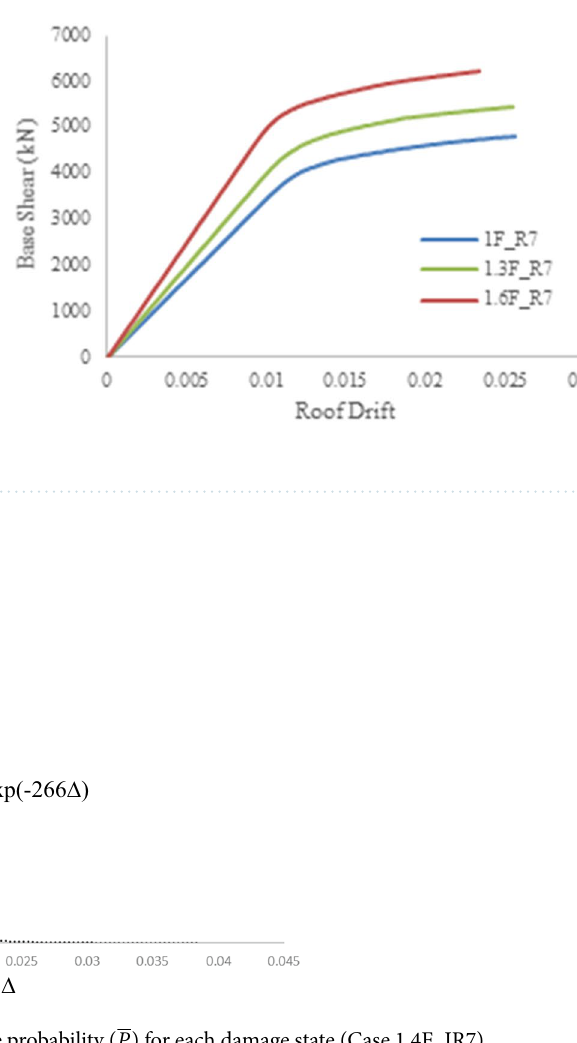
are applied in a displacement-controlled manner in 100 incremental steps until the loads reached the target displacement for each structure, according to ASCE41-17. Afterward, the pushover curve is obtained for each structure. The target displacement for the three AEP (i.e., PGA of 0.58, 0.35, and 0.18 g) is determined for the earthquakes with the exceedance probabilities of 2, 10, and 50% in 50 years. For instance, the pushover curves for three types of 7-story regular structures and the structures designed based on the design earthquake of all four types are presented in Fig. 6. Figure 7 and Table 3 describe the objective function of LCC for the 1.4F_IR7 model. The objective function for the model is described as follows: the pushover analysis result provides three pairs of maximum inter-story Fig. 7. The derived function is used to calculate the annual exceedance probability, P, of the seven damage states listed in Table 1. The P values are substituted into the Eqs. (6) and (7) to calculate the LCC value as a function of the initial cost. As an illustration, all the calculations for 1.4F_IR7 are listed in Table 3. Tables 4, 5, 6 and 7 present the structural results including the total weight of steel sections for all cases as well as their initial, indirect, and LCCs. The 1F_Yi represents the results of the design earthquake. Moreover, the LCC of all buildings is plotted in Fig. 8. As shown in Tables 4, 5, 6 and 7, higher seismic design loads led to higher structure weight and, thus, lower initial costs and lower indirect costs caused by earthquake event probability. As shown in Fig. 9, it is worth noting that for the regular 7-story structure the LCC significantly reduces (higher than 30%) despite the small increase (less than 5%) in the initial cost. It indicates that the LCC is mostly affected by indirect costs rather than direct costs. However, Fig. 8 illustrates that the increment of seismic design loads after a step does not significantly affect the LCC, and increasing the initial cost does not result in lower LCCs. Hence, 1.5F_IR10, 1.5F_R10, 1.5F_IR7, and 1.4F_R7 models can be considered as the LCC-based optimal structures for regular 7-story, irregular 7-story, regular 10-story, and irregular 10-story, respectively.